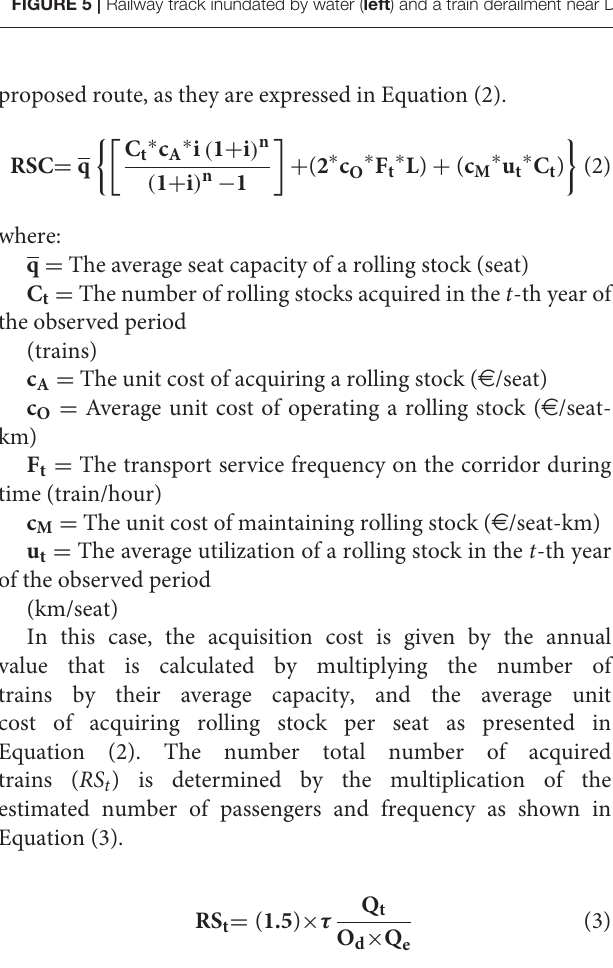
proposed route, as they are expressed in Equation